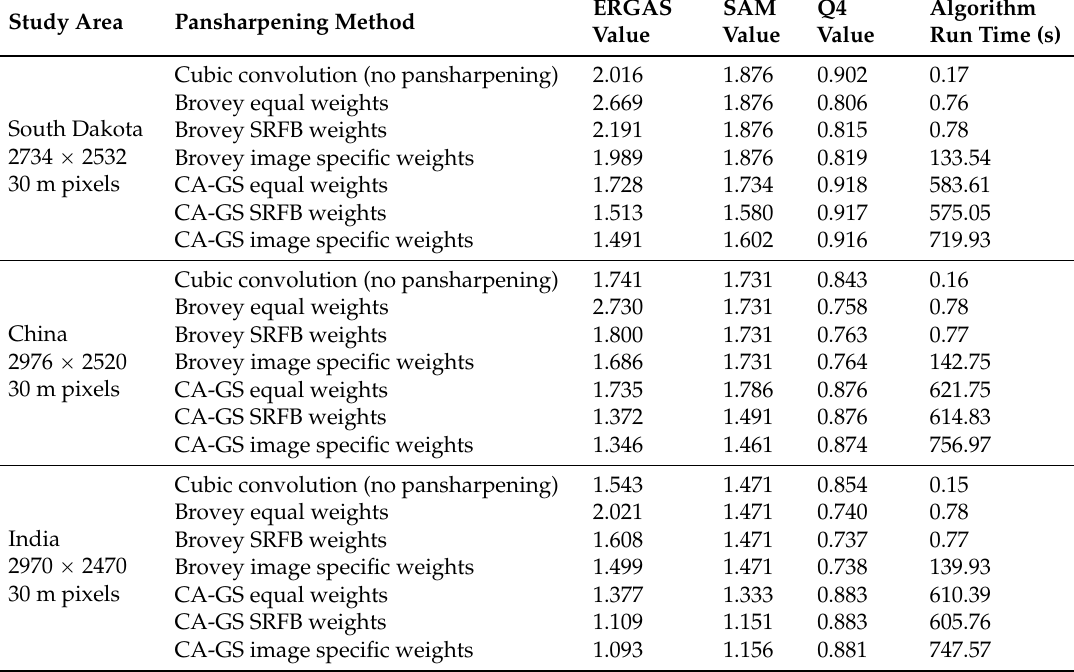
Table 3. Quantitative comparison of the Brovey and context adaptive Gram Schmidt (CA-GS) pansharpening results for the South Dakota (Figure 3), China (Figure 4), and India (Figure 5) red, green, blue and NIR 12 bit images. The ERGAS metric has a zero value when there is no spectral distortion and increasingly positive value with greater distortion. The SAM metric has a zero value when there is no spectral distortion and increasingly positive value with greater distortion. The Q4 index has a value of unity when there is no spatial and spectral distortion and smaller values down to zero with increasing distortion. The evaluation values shown in bold indicate less distortion than the cubic convolution resampled (no-pansharpening) results. The computational algorithm run time (Section 3.4.4) is also shown.